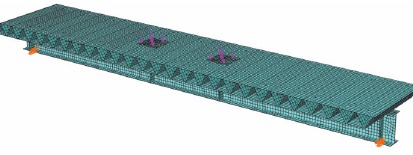
Figure 11: FE model of FRP-steel girder system.